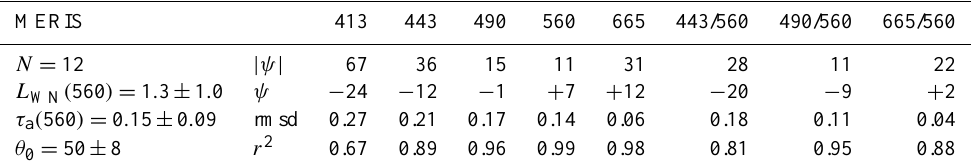
Table 6. Statistical results from the analysis of MERIS (3rd Reprocessing) and AERONET-OC L WN , and their ratios at specific center wavelengths for the match-ups determined at GLR with 1t = ± 2h. Symbols and units are the same as in Table 1.